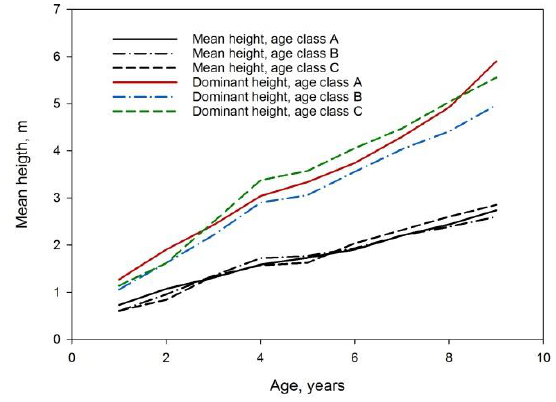
Figure 3. The number of naturally regenerated birch seedlings.